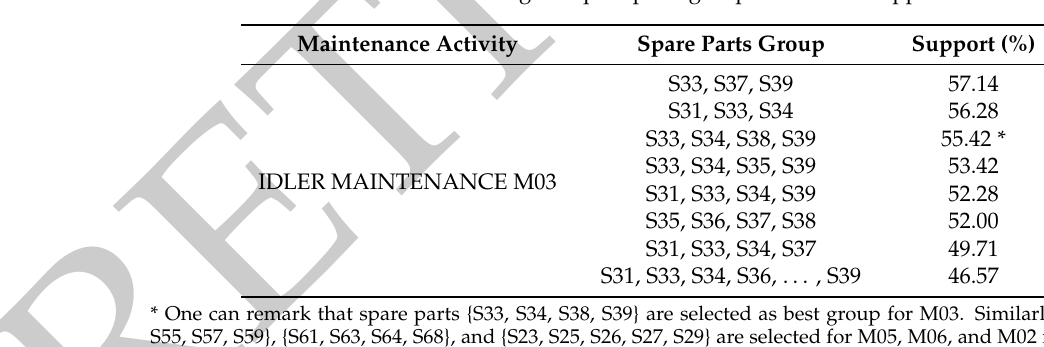
Table 10. Selecting the spare parts group with a 50%